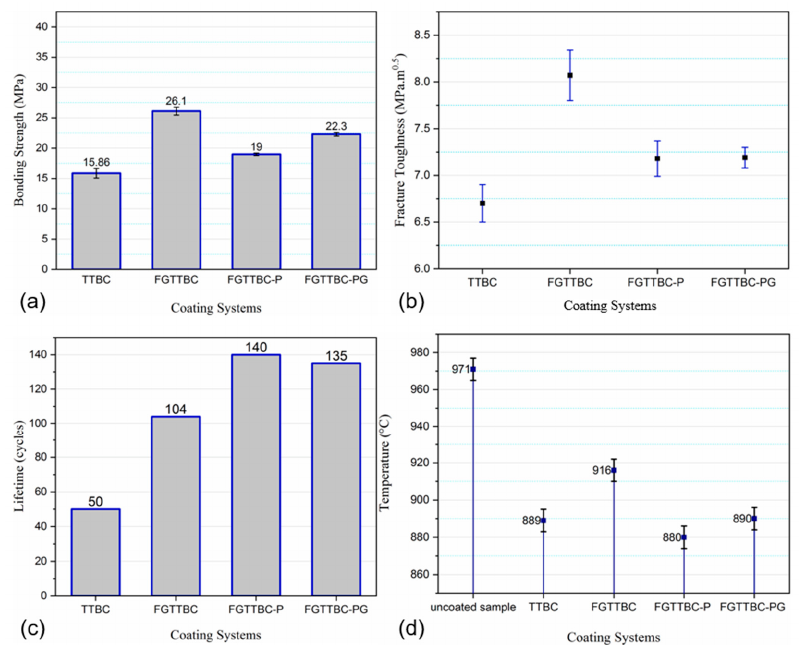
Figure 23. ( a ) Bonding strength ( b ) the fracture toughness ( c ) the thermal shock lives ( d ) substrate temperature diagrams of all coated samples [147] .